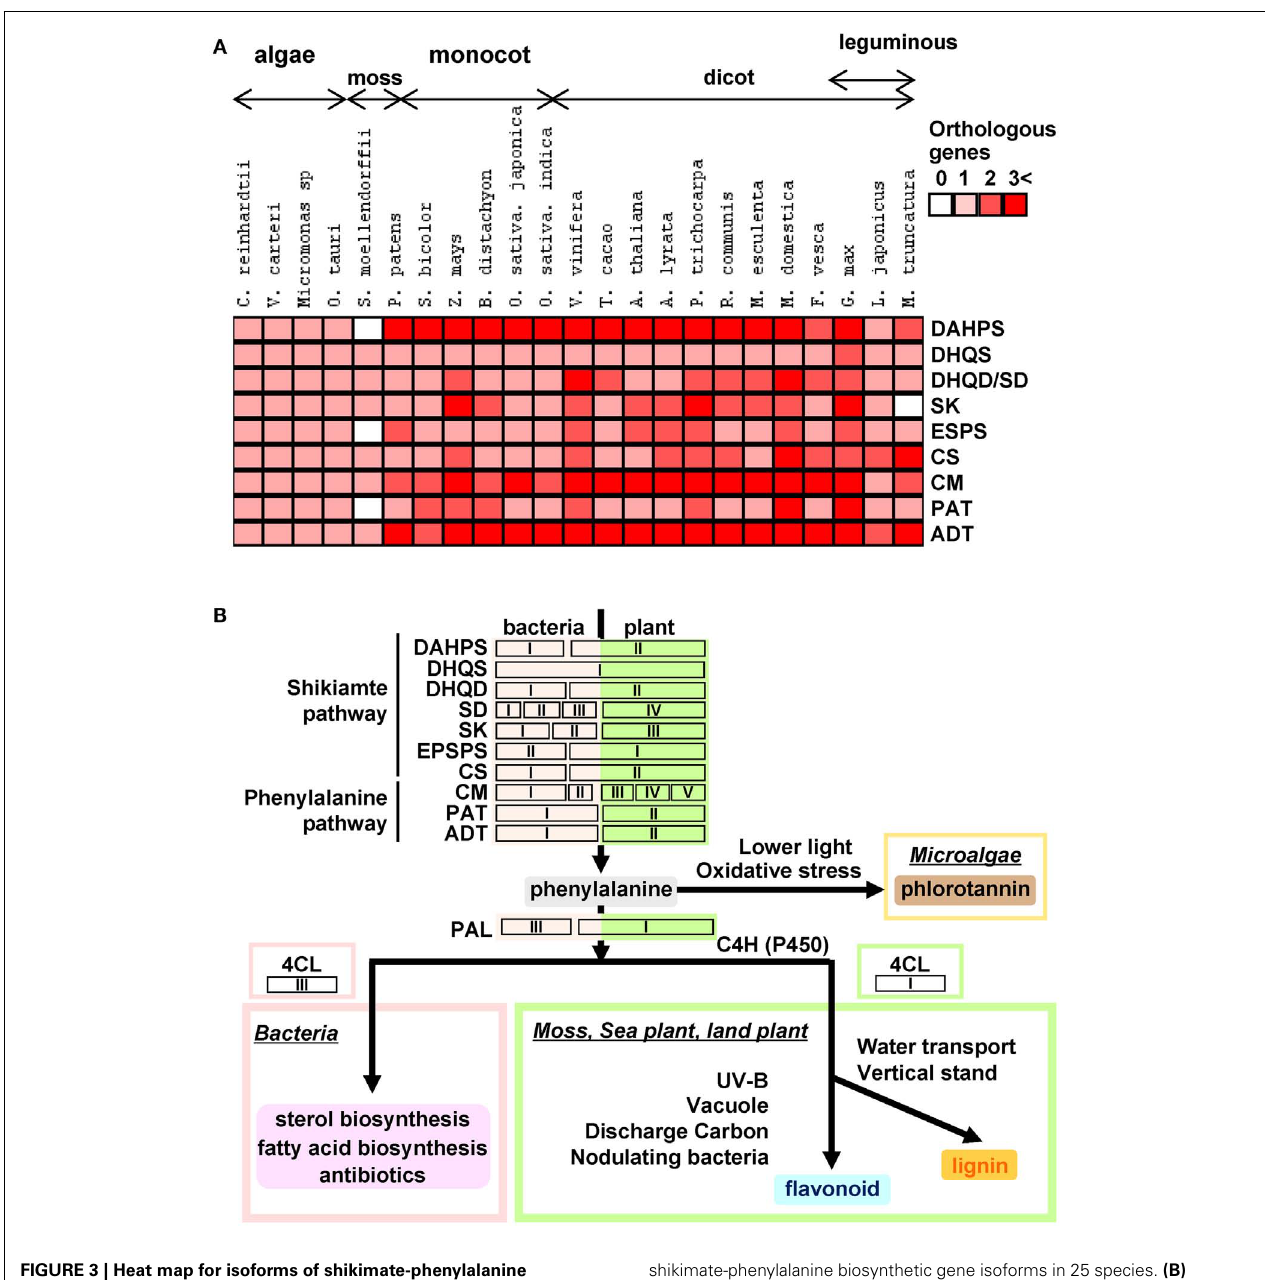
FIGURE 3 | Heat map for isoforms of shikimate-phenylalanine biosynthetic genes in plant genomes and hypothetical scheme for the evolution of phenylalanine derived phenolic secondary metabolism. (A) Heap map overview of number of